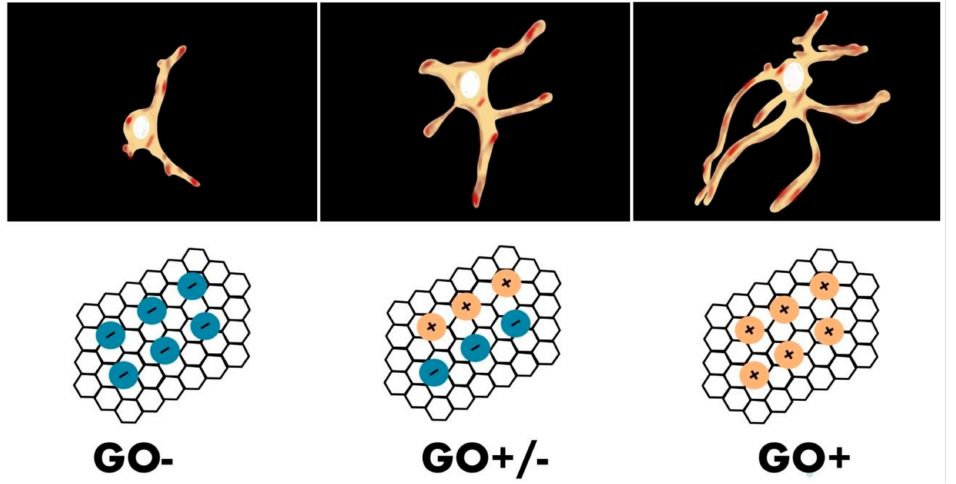
Figure 4. Diagram showing the influence of the scaffold load on the construction of the neuron. Immunochemistry staining images of single hippocampal neurons after 7 days of culture on GO– COOH, GO–OCH3, GO–PABS, and GO–NH2 (from left to right). Adipose derived stem cells (ADSCs), due to their frequent occurrence in vivo, are a good source of cells for research; therefore, they can be a good alternative to MSCs